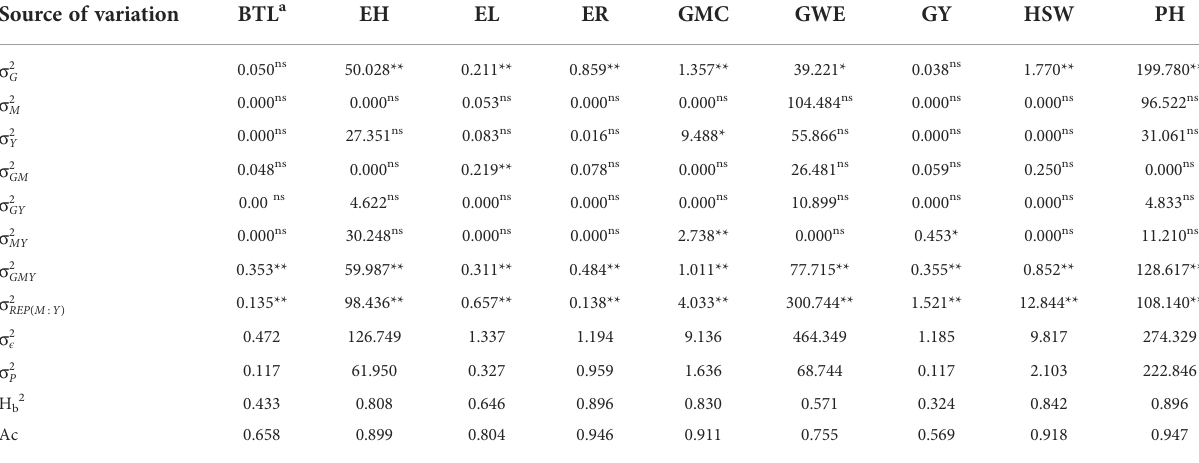
TABLE 3 Variance components for the main effect of genotypes ( s 2 G ) , mega-environments ( s 2 M ), cultivation year ( s 2 Y ), and their interactions estimated for nine traits assessed in 26 maize hybrids. Source of variation